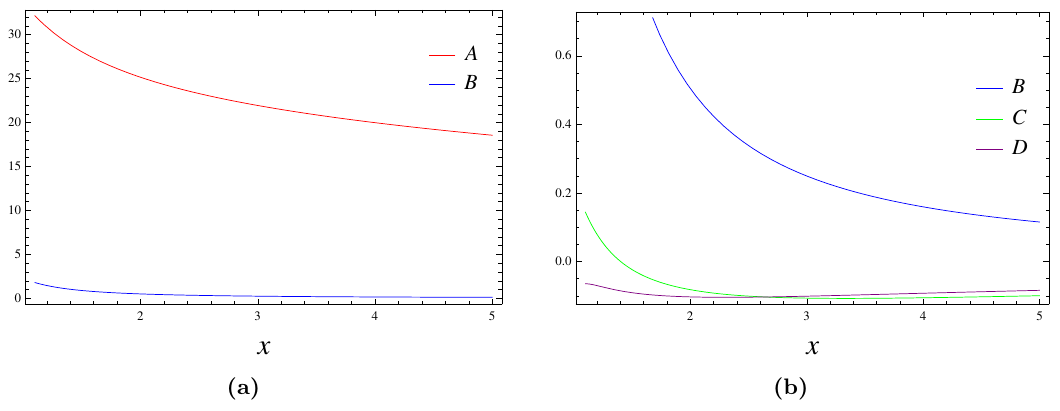
Figure 2. Plots of the functions A , B , C and D